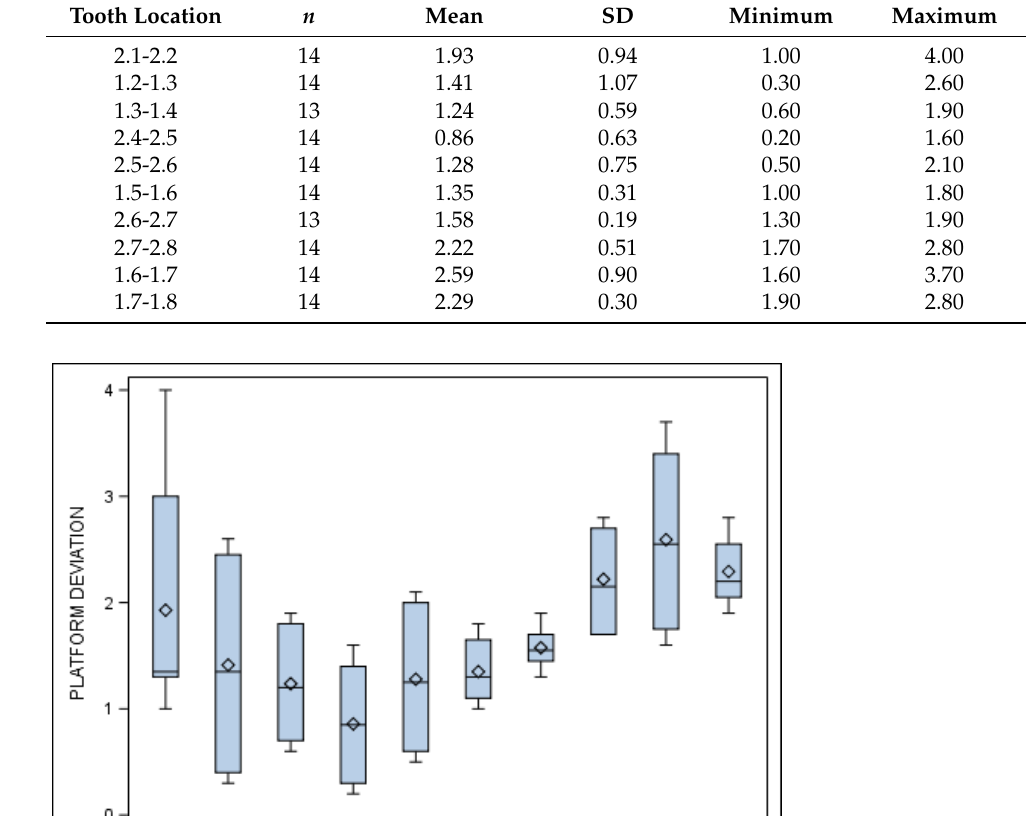
Figure 7. Box plot of the apical deviations in planned and performed orthodontic micro-screws between computer-aided static navigation technique and conventional freehand technique study groups.